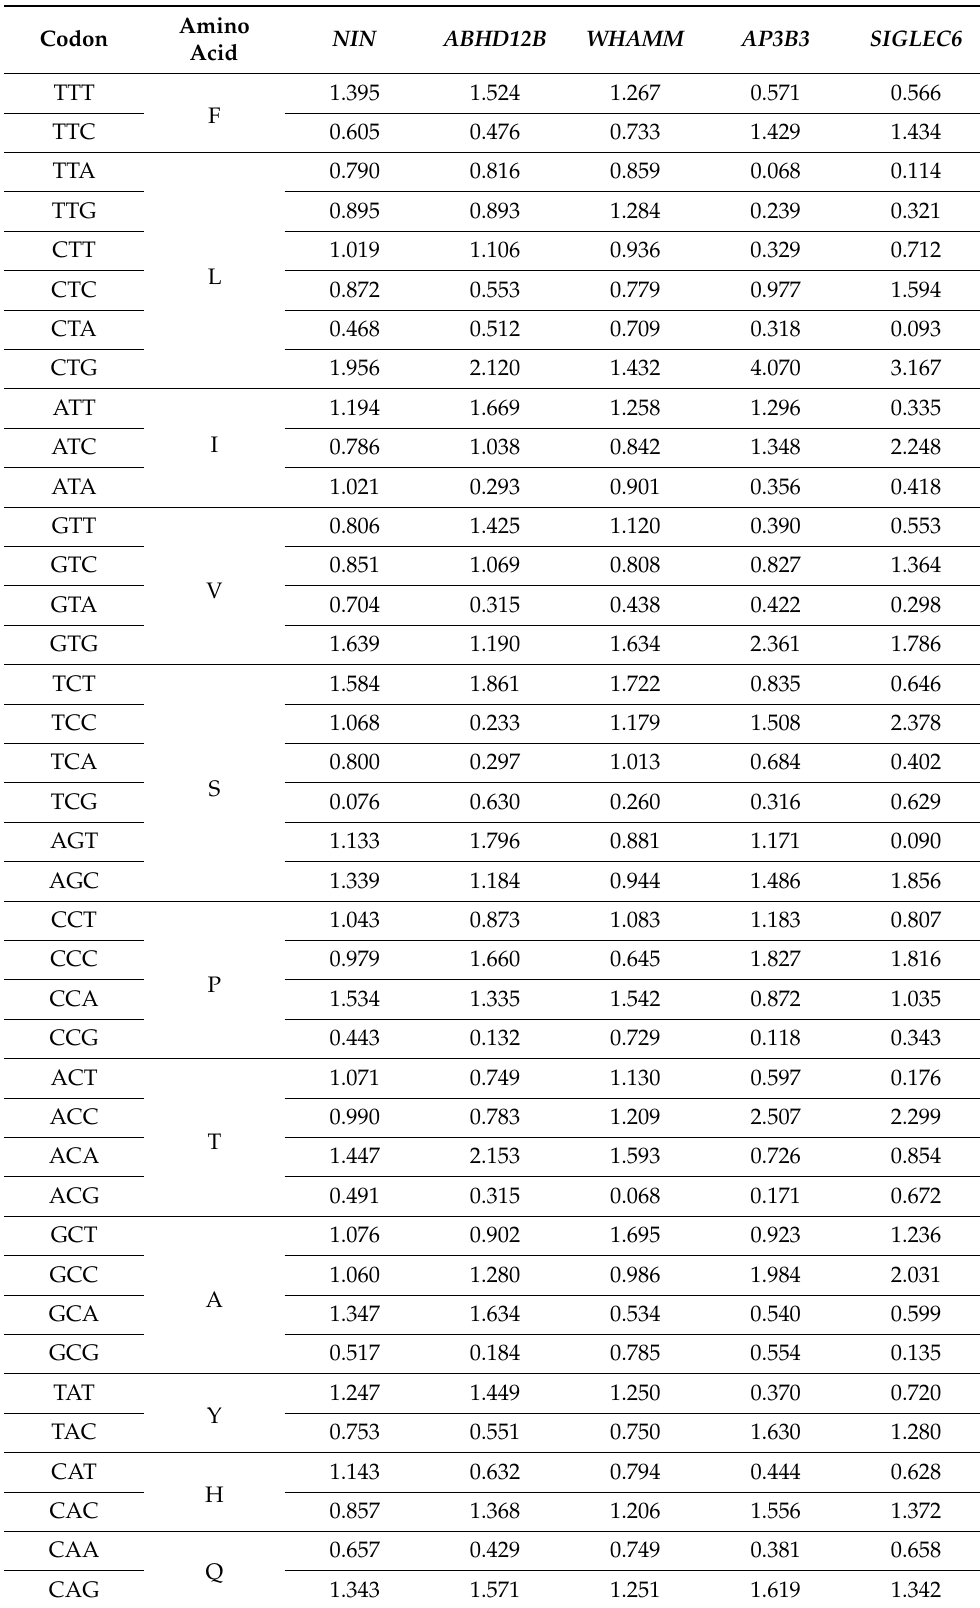
Table 1. RSCU of NIN, ABHD12B, WHAMM, AP3B3, and SIGLEC6